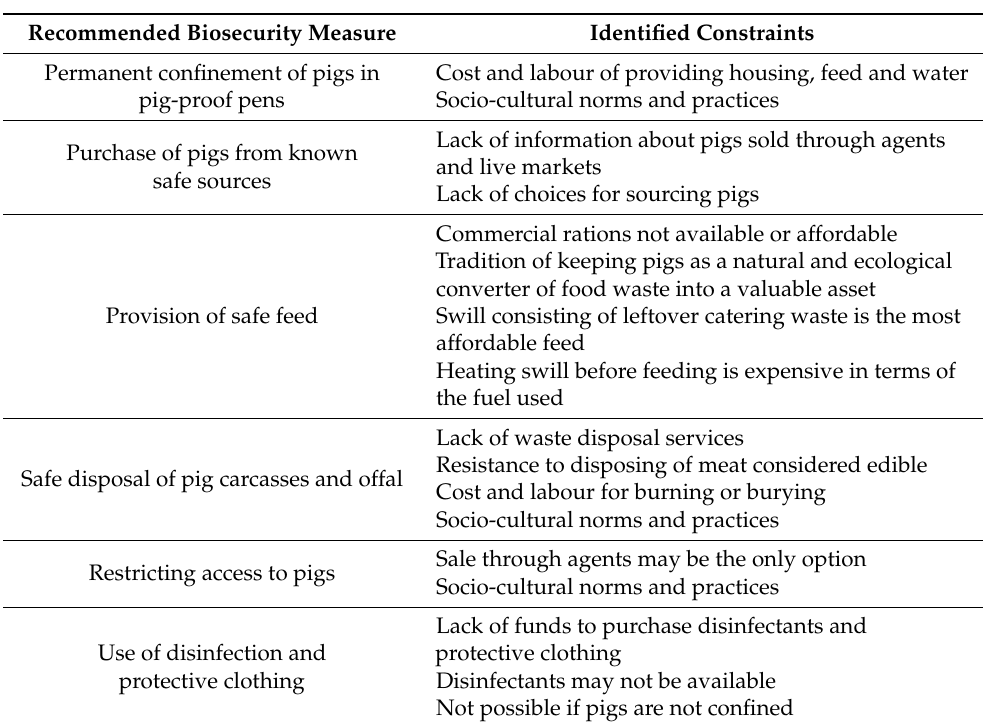
Table 3. Constraints identified for implementation of recommended basic biosecurity measures based on literature cited in the text and personal experience of the